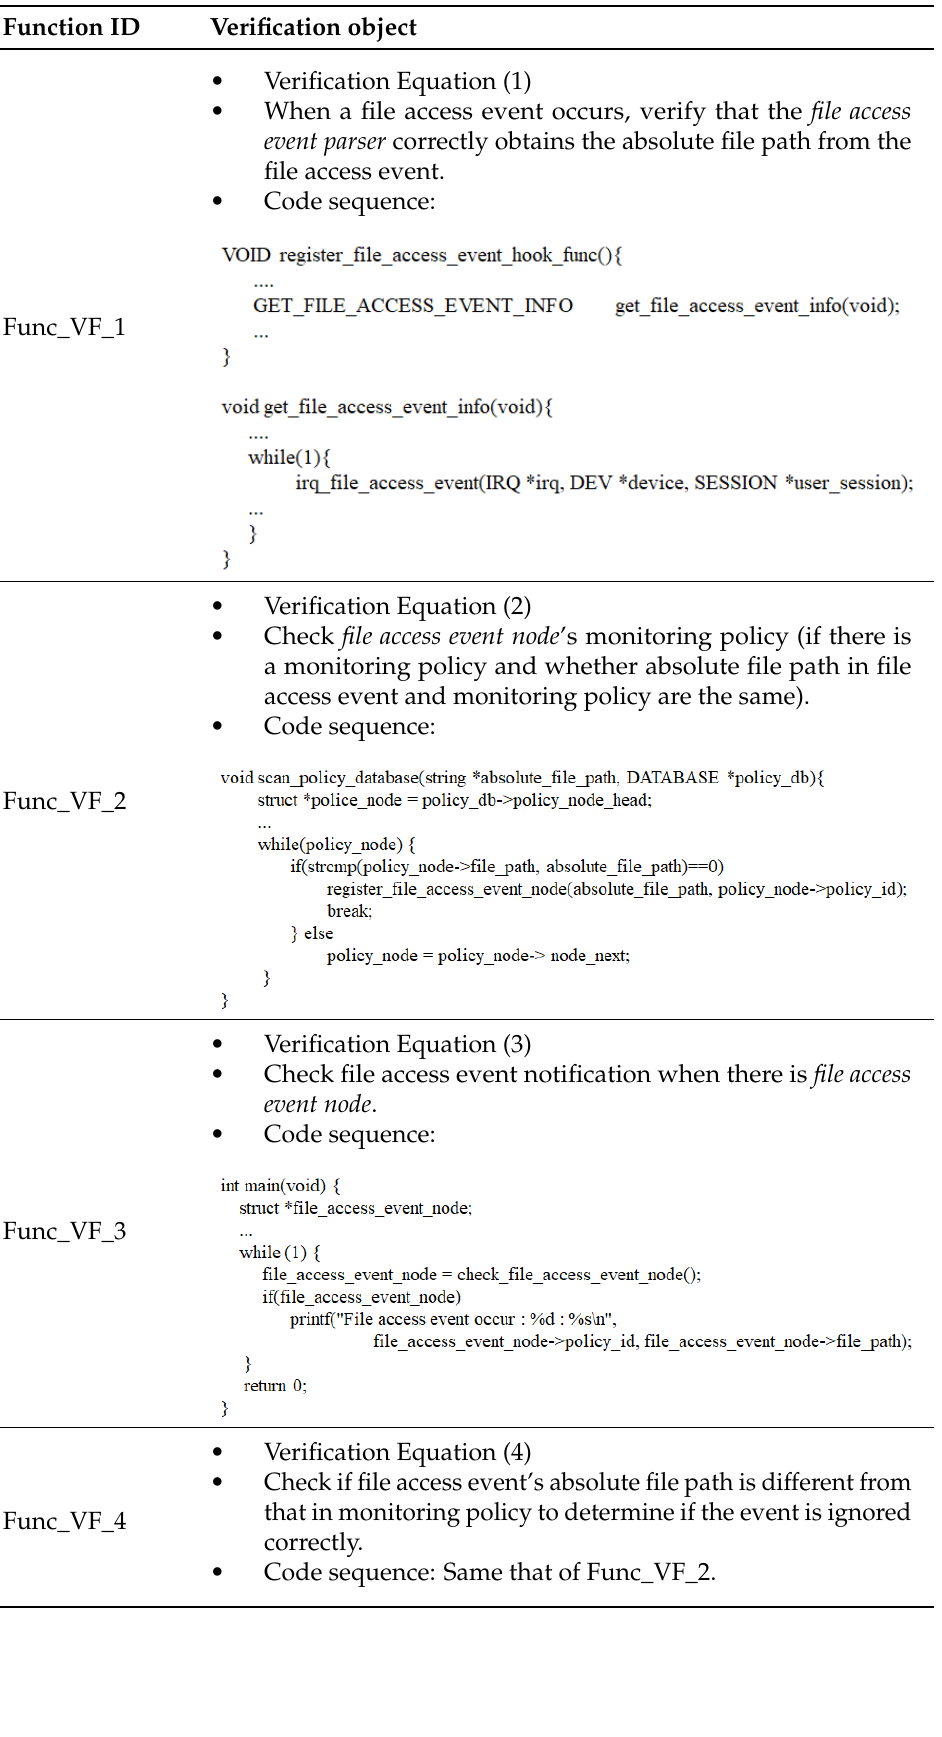
Table 3. Function verification